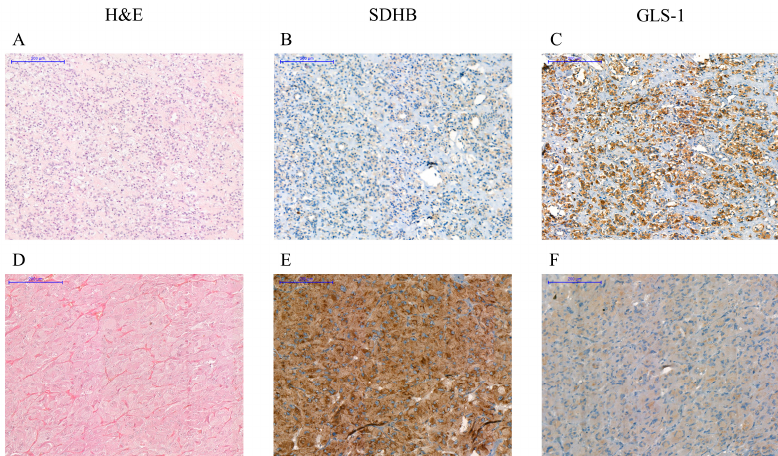
(Figure 7) and Patient No. 5. The third GLS-1 overexpressing RET -mutant Pheo sample was obtained from a patient with MEN2A syndrome with bilateral Pheo (Patient No. 6, the GLS-1 positive sample was the Pheo removed from right side).